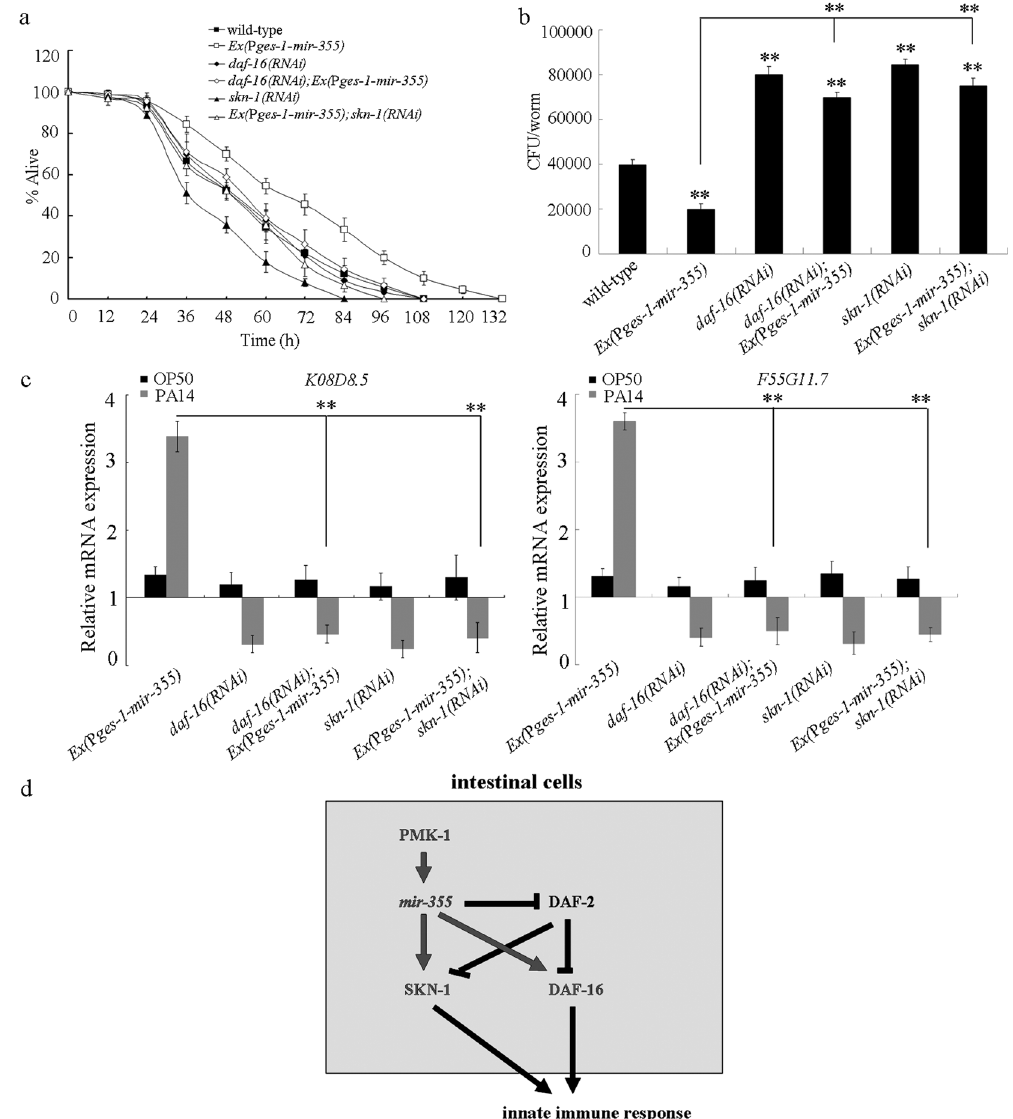
Figure 8. Genetic interaction between mir-355 and DAF-16 or SKN-1 in the regulation of innate immune response to P. aeruginosa PA14 infection. ( a ) Genetic interaction between mir-355 and DAF-16 or SKN-1 in the regulation of survival in P. aeruginosa PA14 infected nematodes. Statistical comparisons of the survival plots indicate that, after P. aeruginosa PA14 infection, the survival of daf-16(RNAi);Ex( P ges-1-mir-355) or Ex( P ges- 1-mir-355);skn-1(RNAi) was significantly different from that of Ex( P ges-1-mir-355) ( P < 0.001). Bars represent mean ± SD. ( b ) Genetic interaction between mir-355 and DAF-16 or SKN-1 in the regulation of P. aeruginosa PA14 CFU in the body of nematodes. Bars represent mean ± SD. ** P < 0.01 vs wild-type (if not specially indicated). ( c ) Genetic interaction between mir-355 and DAF-16 or SKN-1 in the regulation of expression patterns of putative antimicrobial genes in P. aeruginosa PA14 infected nematodes. Normalized expression is presented relative to wild-type expression. Bars represent mean ± SD. ** P < 0.01. ( d ) A diagram showing the molecular basis for mir-355 in the regulation of innate immune response to P. aeruginosa PA14